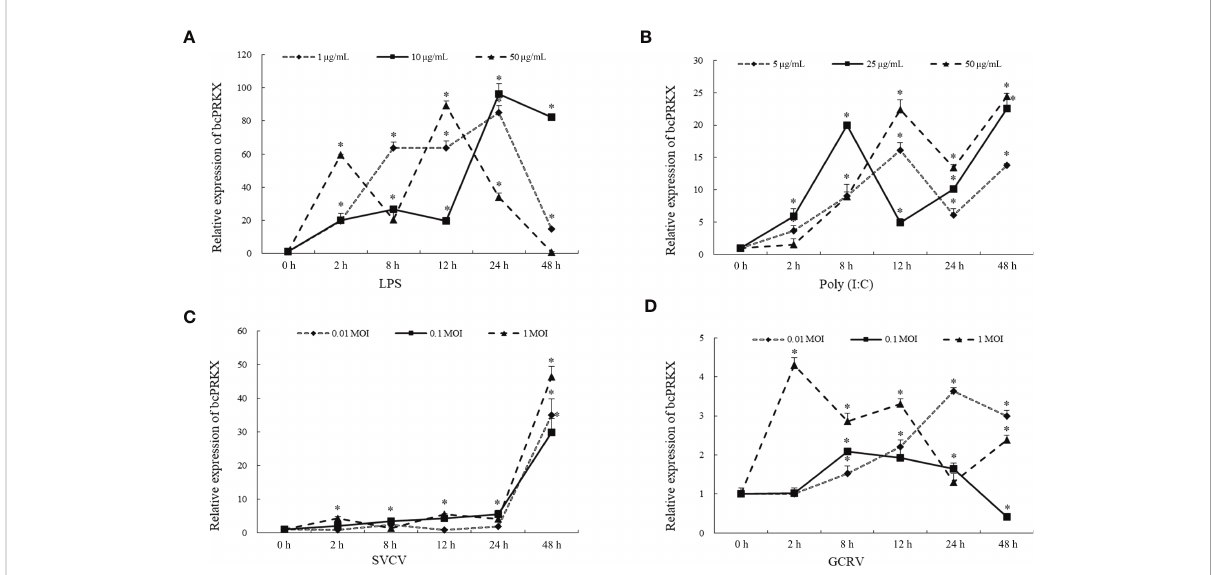
FIGURE 3 bcPRKX mRNA expression in response to different stimuli. MPK cells were treated with (A) LPS (1, 10 and 50 m g/mL), (B) Poly (I:C) (5, 25 and 50 m g/mL), (C) SVCV (0.01, 0.1 and 1 MOI) or (D) GCRV (0.01, 0.1 and 1 MOI) respectively. The cells were harvested at 0, 2, 8, 12, 24 or 48 h post- treatment separately, then subject to RNA isolation and qPCR analysis. Asterisk (*) stands for statistical difference (p<0.05).